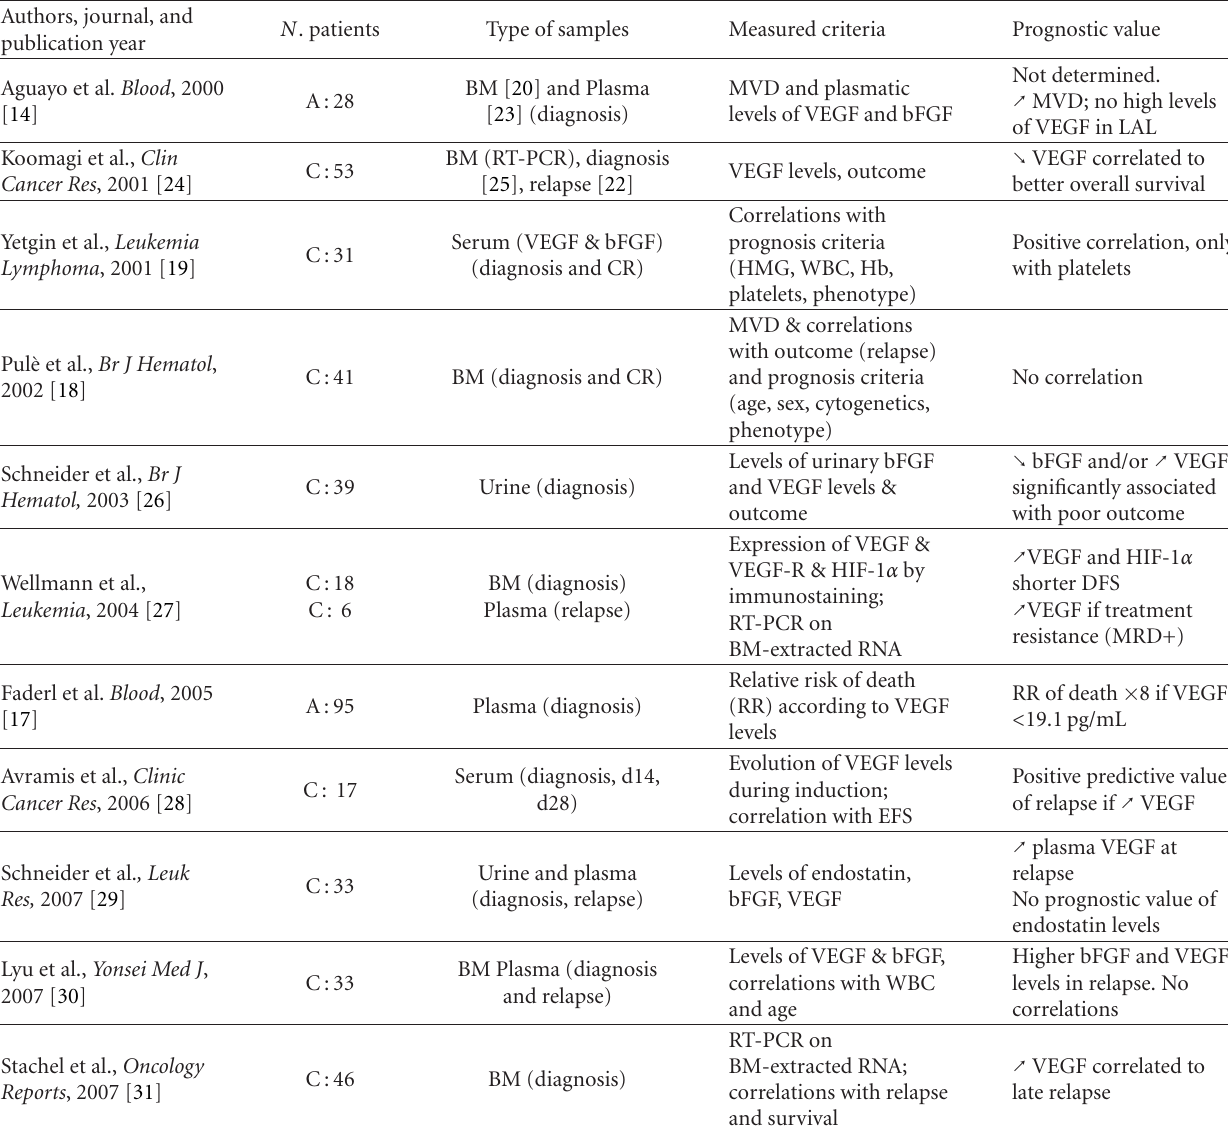
Table 1: Main studies concerning the prognostic value of bFGF and VEGF in adult (A) and childhood (C)